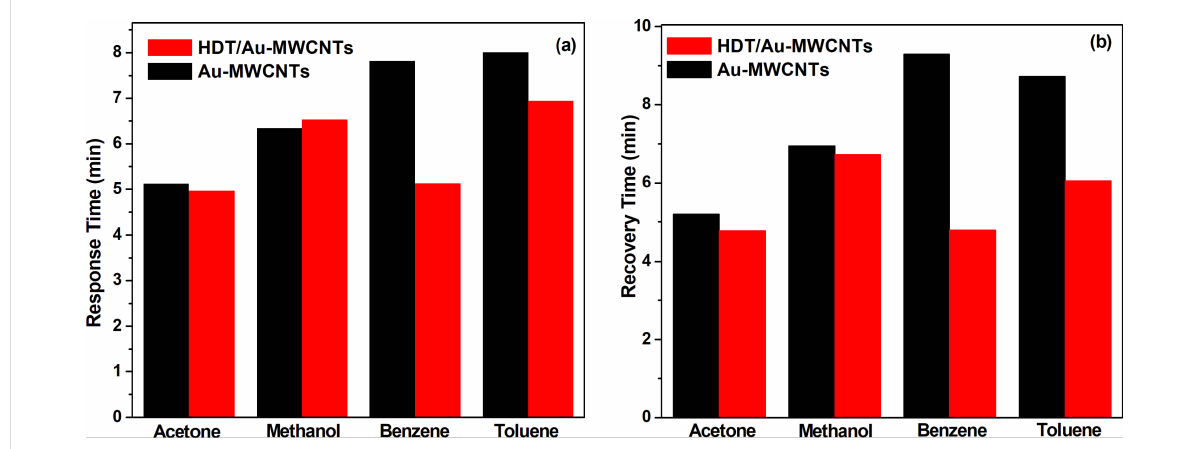
Figure 8: (a) Response and (b) recovery times of Au-MWCNT and HDT/Au-MWCNT sensors towards tested vapours.